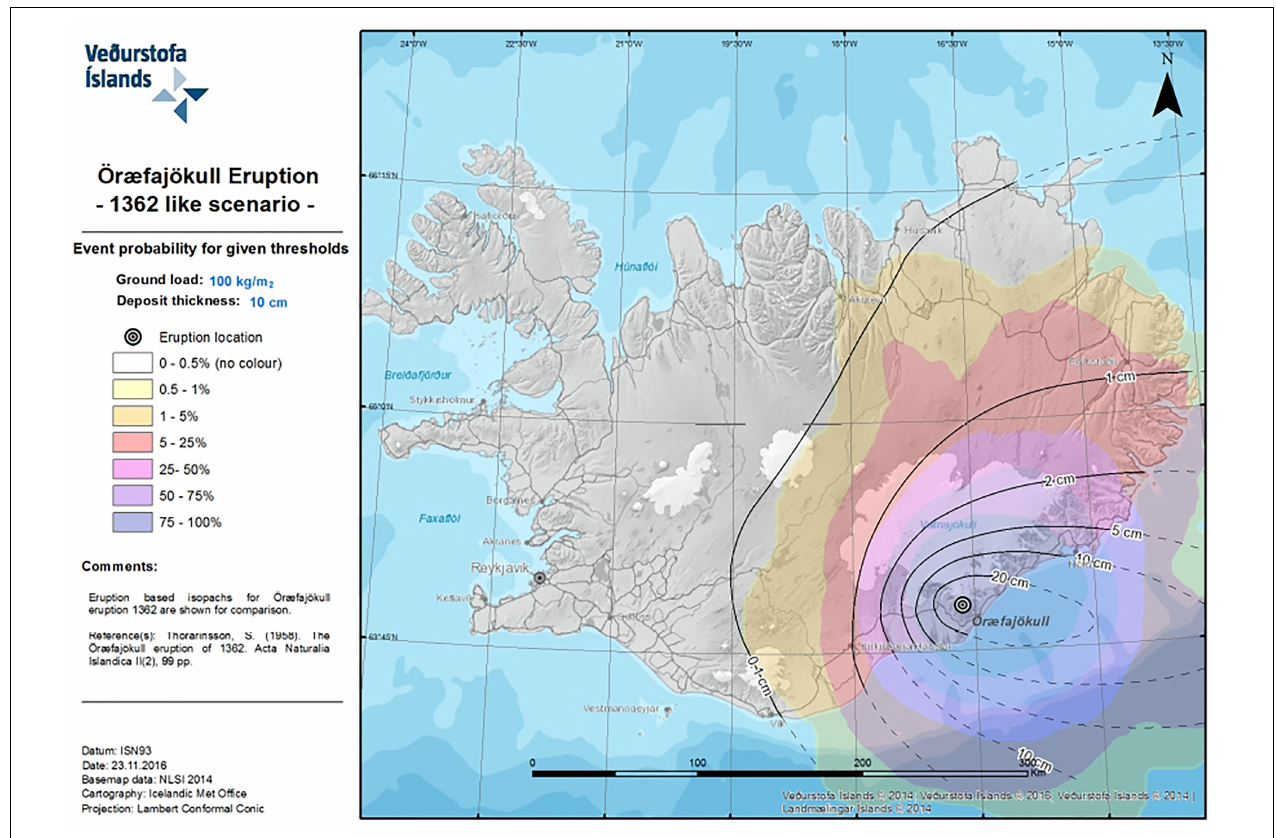
FIGURE 7 | Probabilistic hazard map for tephra loading higher than 100 kg/m 2 given an eruption at Öræfajökull as 1362 AD. The isopachs reconstructed by Thorarinsson (1958) are reported as a reference with black